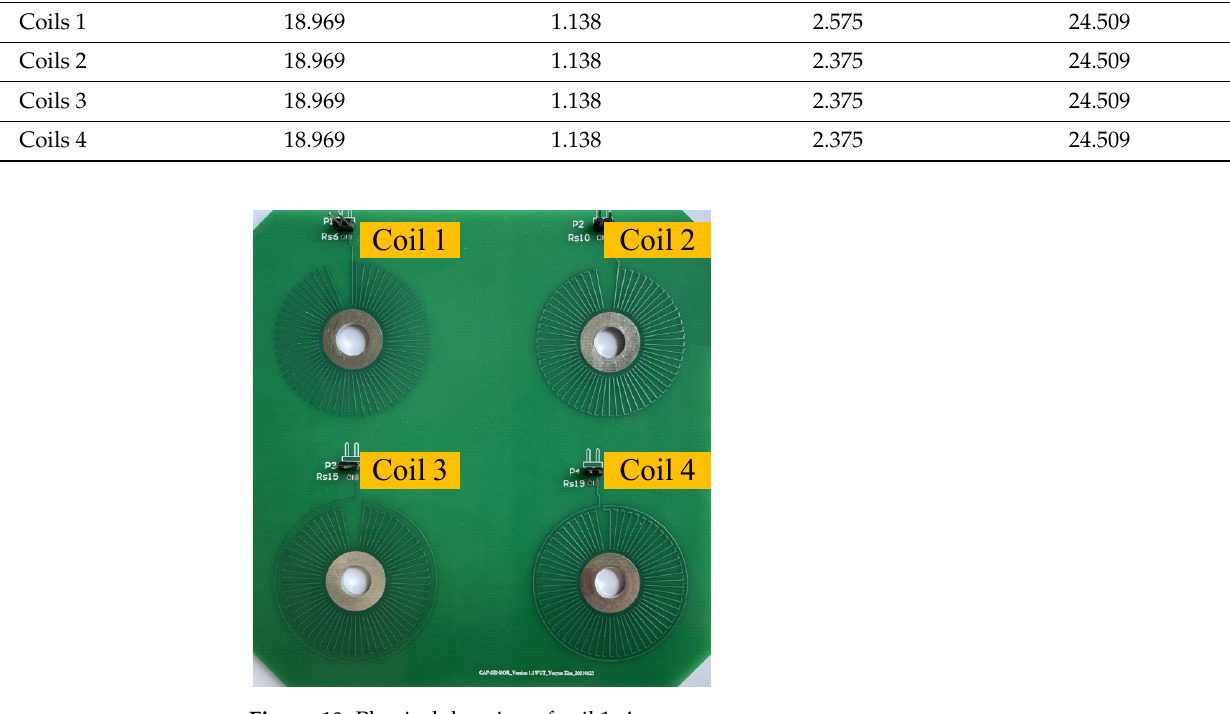
Figure 10. Physical drawing of coil 1–4.